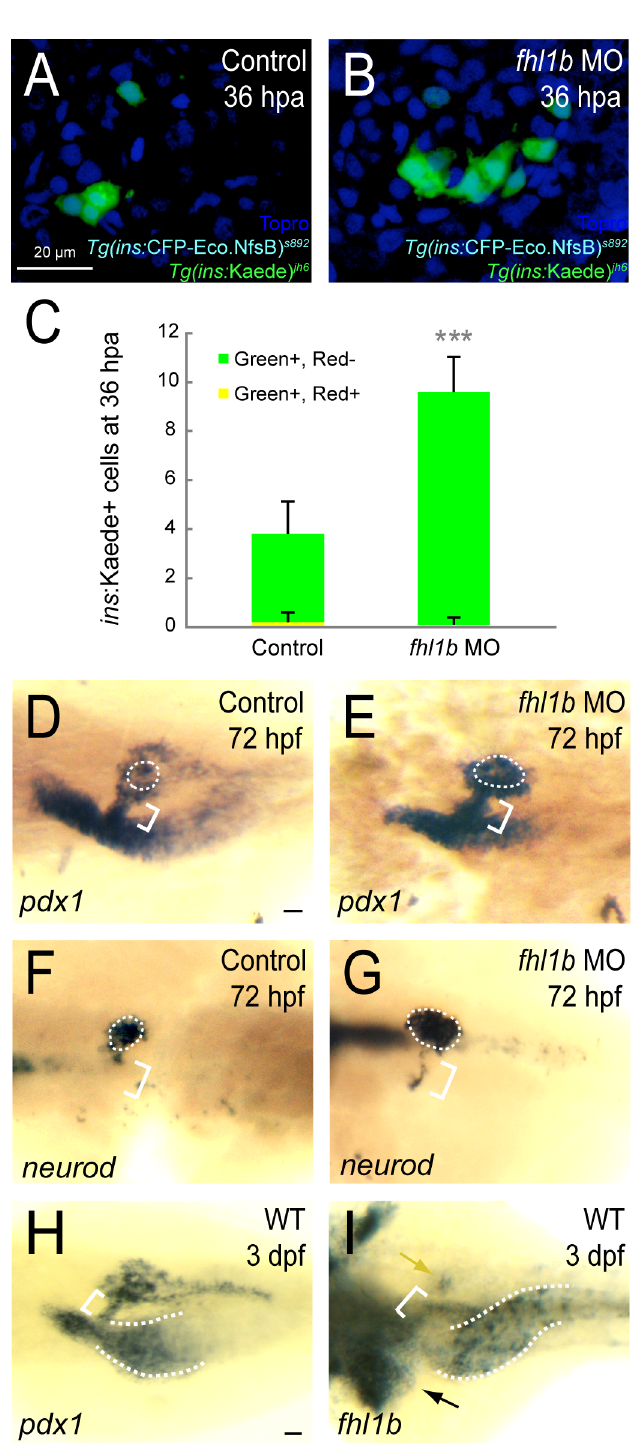
Fig 6. Reduction of Fhl1b activity enhances the capacity of β -cell regeneration. (A and B) Confocal images of [ Tg(ins : CFP-NTR) s892 ; Tg(ins : Kaede) jh6 ] control larvae (A) and fhl1b MO-injected (B) larvae at 36 hours-post-ablation (hpa) stained with Topro (blue). A greater number of β -cells regenerated in recovering fhl1b -MO injected larvae (B) compared to that of control larvae (A). (C) Quantification of the number (mean ± SD) of regenerated and survived β -cells. After photoconversion and ablation, the survived β -cells are red and green (yielding a combined color of yellow), whereas the newly formed β -cells are green only. 3.8 ± 1.3 β